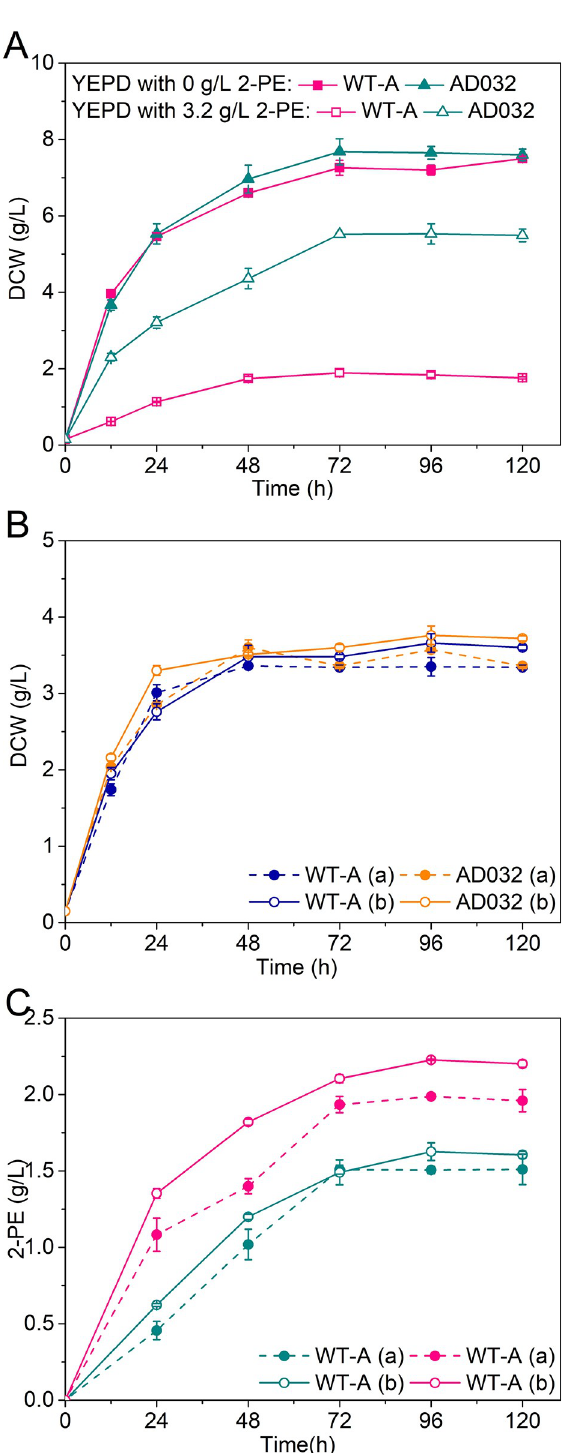
Fig 3. Improvement of cell growth and 2-PE production by adaptive laboratory evolution of S . cerevisiae strain AD032. (A) Tolerance of the adaptive strain AD032 and control strain WT-A under 2-PE stress in YEPD medium. (B) Cell growth of control strain WT-A and evolutionary adaptive strain AD032 in the flask fermentation with 4 g/L phenylalanine (a) and 6.7 g/L phenylalanine (b) culture medium. (C) Improvement of 2-PE production of control strain WT-A and evolutionary adaptive strain AD032 in the flask fermentation with 4 g/L phenylalanine (a) and 6.7 g/ L phenylalanine (b) culture medium. Data are presented as the averages of the results of three independent experiments. Error bars show standard